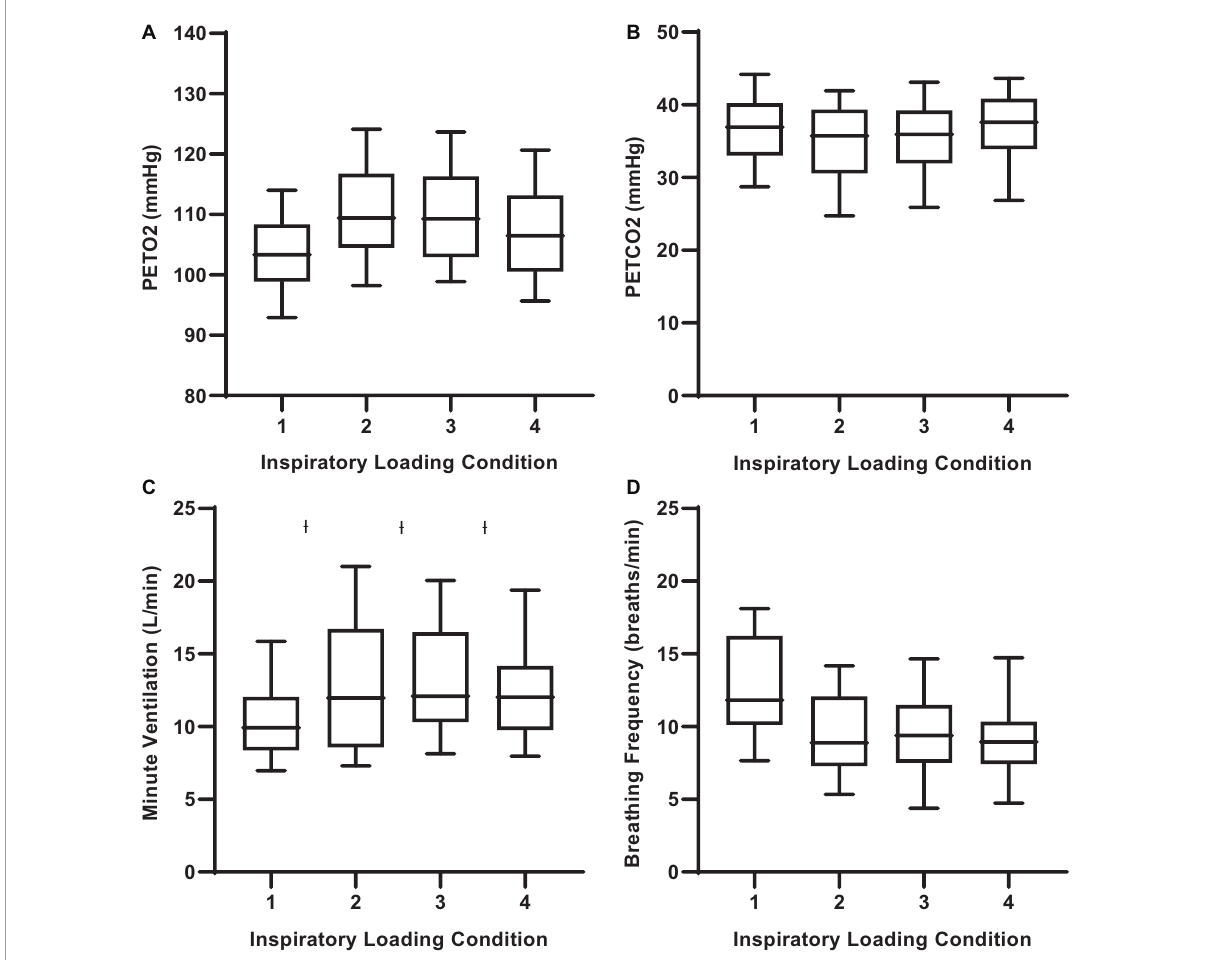
FIGURE3 End-tidal gases and ventilatory responses to inspiratory threshold loading during masked conjunctive continuous performance trials. (A) Depicts the differences in PETO2 across loading conditions. (B) Depicts the differences in PETCO2 across loading conditions. (C) Depicts The differences in minute ventilation across loading conditions. (D) Depicts changes in breathing frequency across loading conditions. The upper and lower limits of the box represent the 95% CI, the horizontal line in the box represents the mean, and the whiskers represent the SEM. P ET O 2 and P ET CO 2 : end-tidal partial pressures of O 2 and CO 2 . I Significant difference from load condition 1, P <